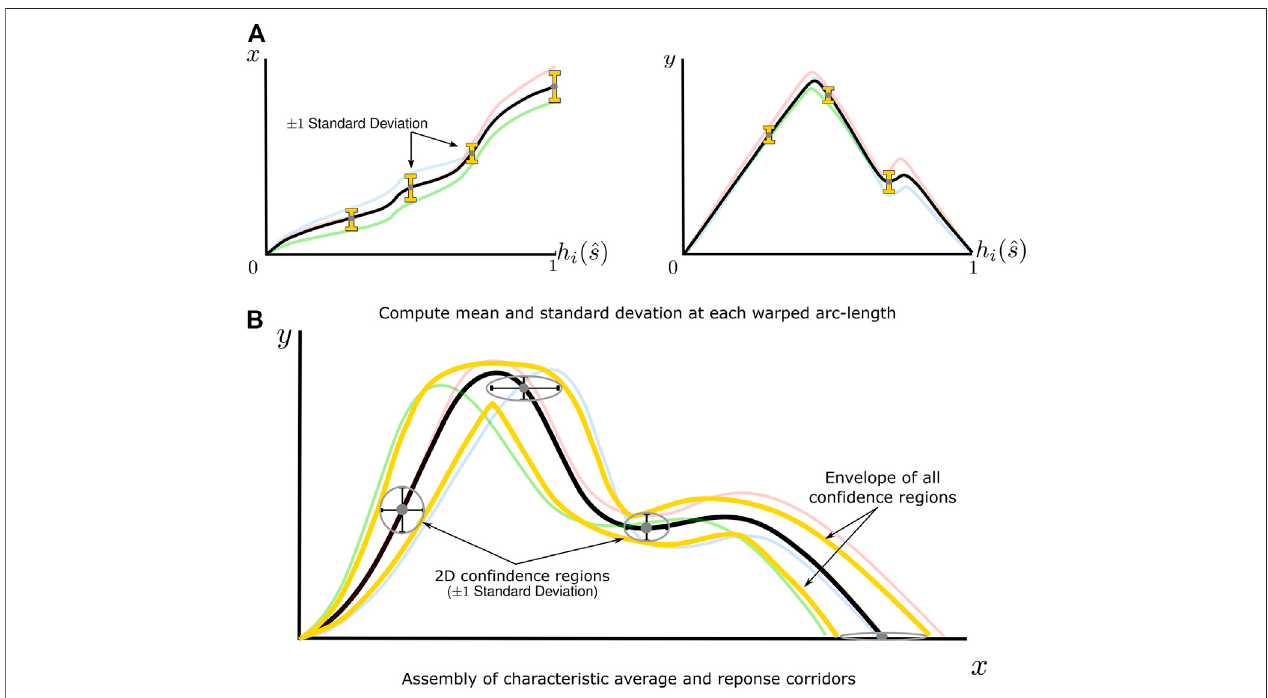
FIGURE5| Agraphicaldepictionofthestatisticalanalysisofre-parameterizedsignalsandconstructionofresponsecorridors (A) Themeanandstandarddeviation of signals are computed point-wise in the arc-length space for x and y before being combined. (B) Mean x and y values make up the characteristic average, while standard deviations form elliptical con fi dence regions. The response corridor is de fi ned as the envelope of all elliptical